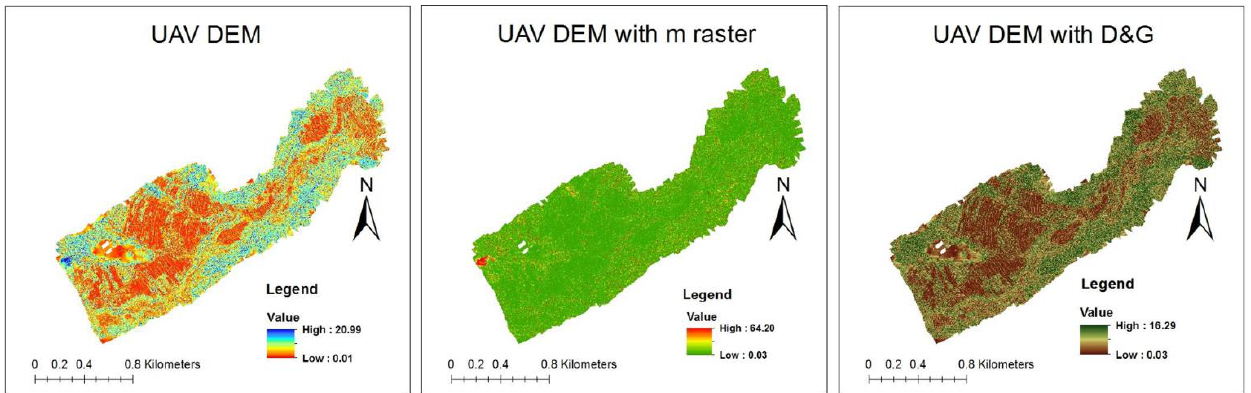
Figure 8: LS factor of UAV DEM with constant slope exponent, spatially distributed slope exponent and with multiple flow